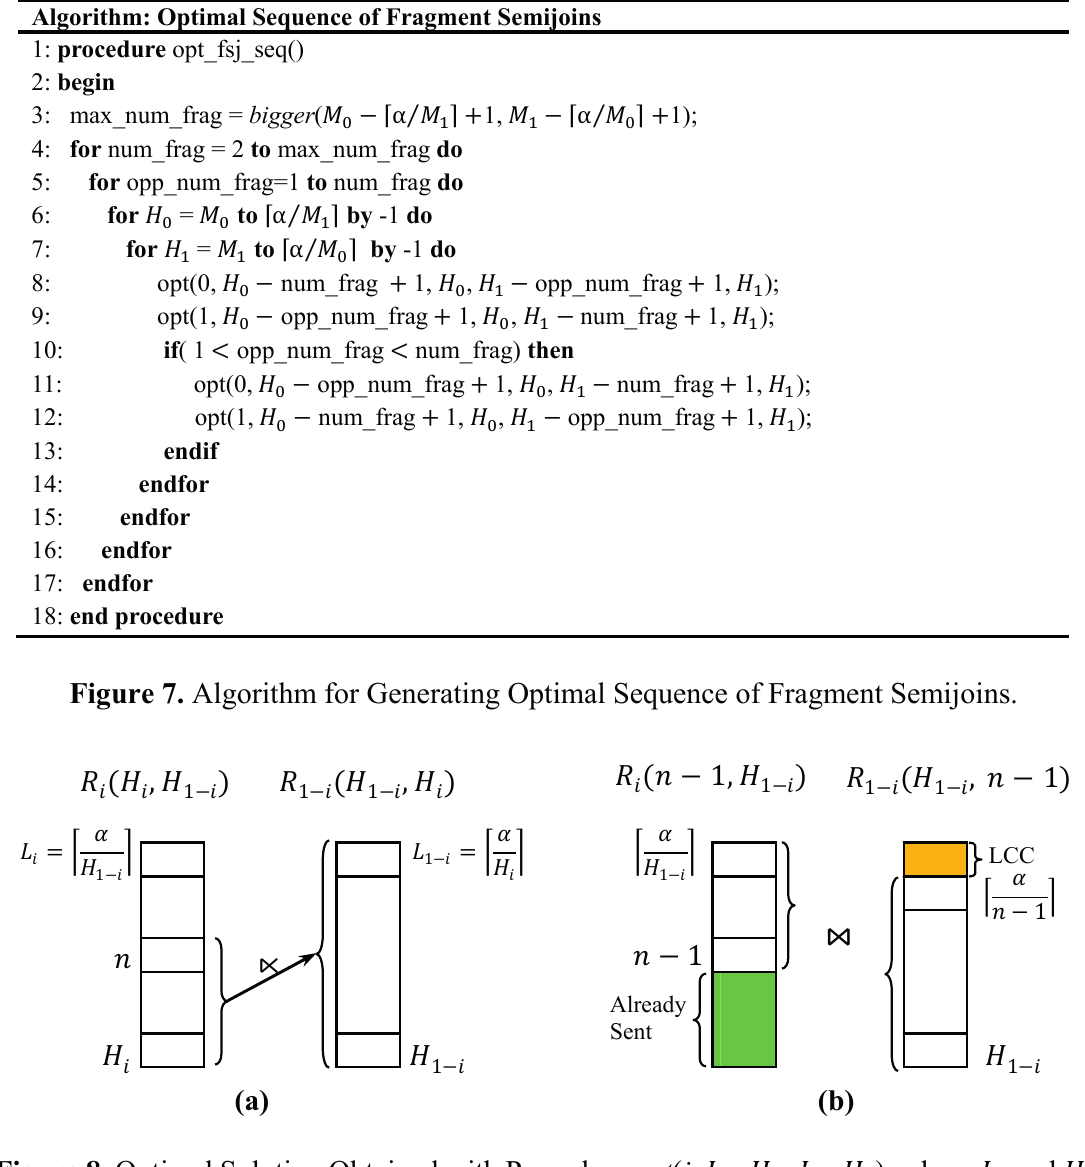
Figure 8. Optimal Solution Obtained with Procedure opt ( i , (cid:1838) are respectively the current lowest and highest count in (cid:1844) (cid:3036) ((cid:1834) ) is obtained; ( b ) using the optimal solution, (cid:1845) for (cid:1845) , (cid:1834) ⋉(cid:3365)∗ (cid:3036) (cid:2869)(cid:2879)(cid:3036) each value of n